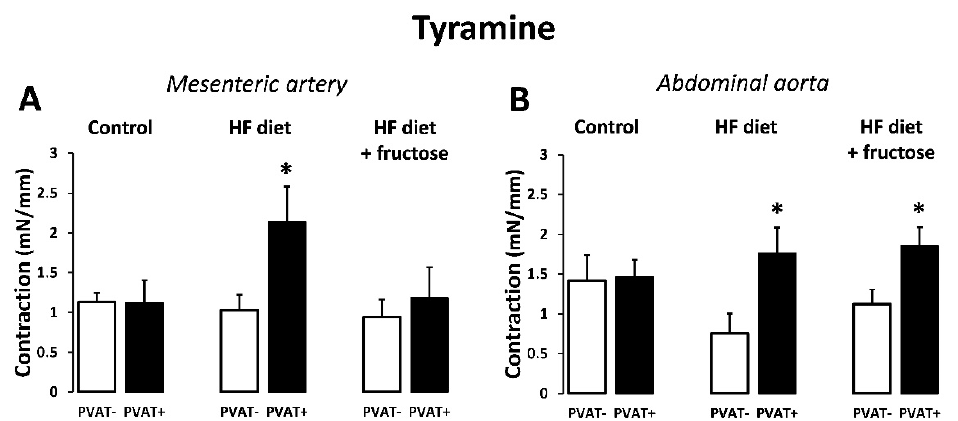
Figure 5. Contractile responses to tyramine (0.1 mM): comparison of PVAT(+) and PVAT( − ) preparations of mesenteric artery ( A ) and abdominal aorta ( B ) in Wistar–Kyoto rats: control, treated with high-fat (HF) diet, and treated with HF diet + fructose. * p < 0.05 vs. PVAT( − ). Values represent means ± SEM; n = 6.